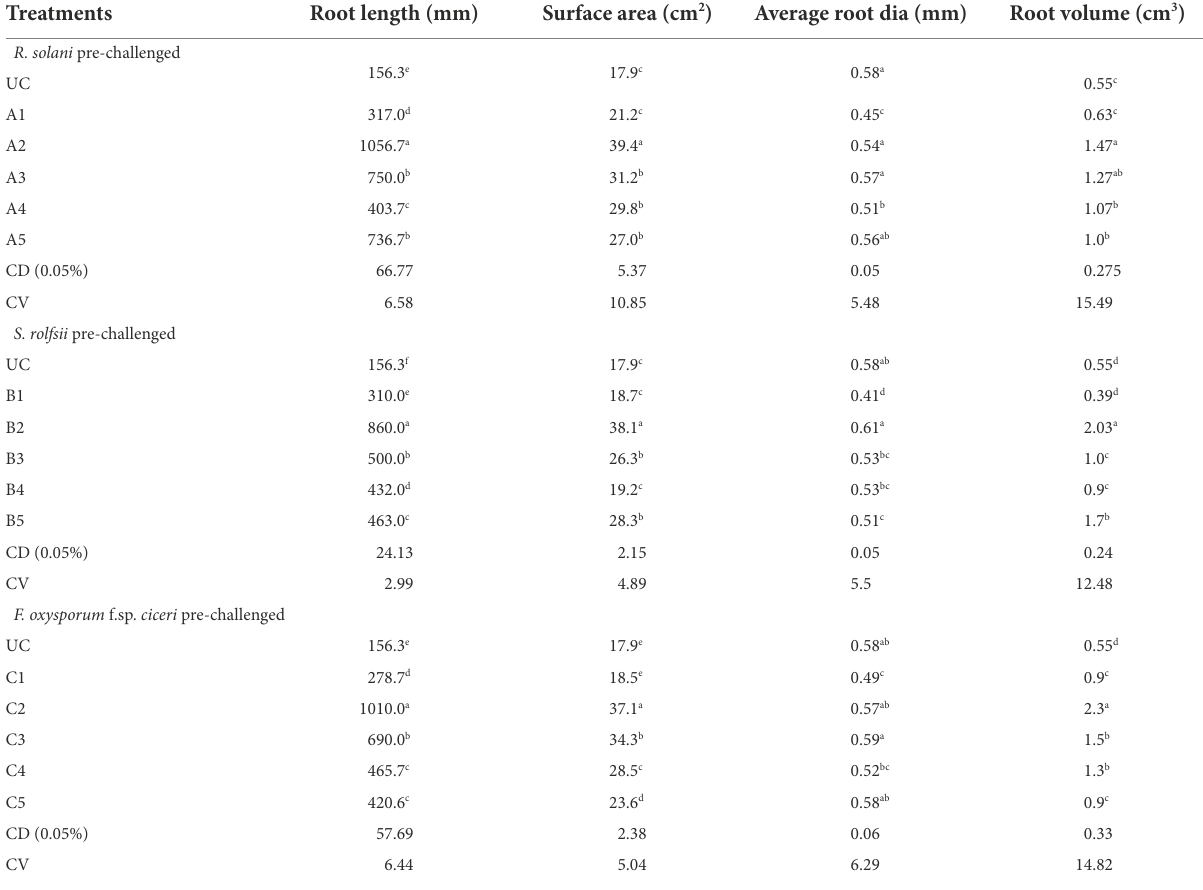
TABLE 5 Effect of bacterial endophytes inoculation on root parameters of chickpea challenged with soil-borne fungal pathogens. Treatments Root length (mm) Surface area (cm 2